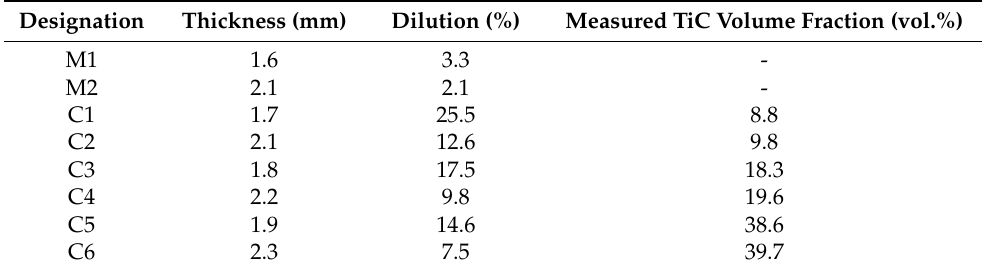
Table 4. Thickness, dilution and TiC volume fraction measurement results; designations in accordance with Table 3.